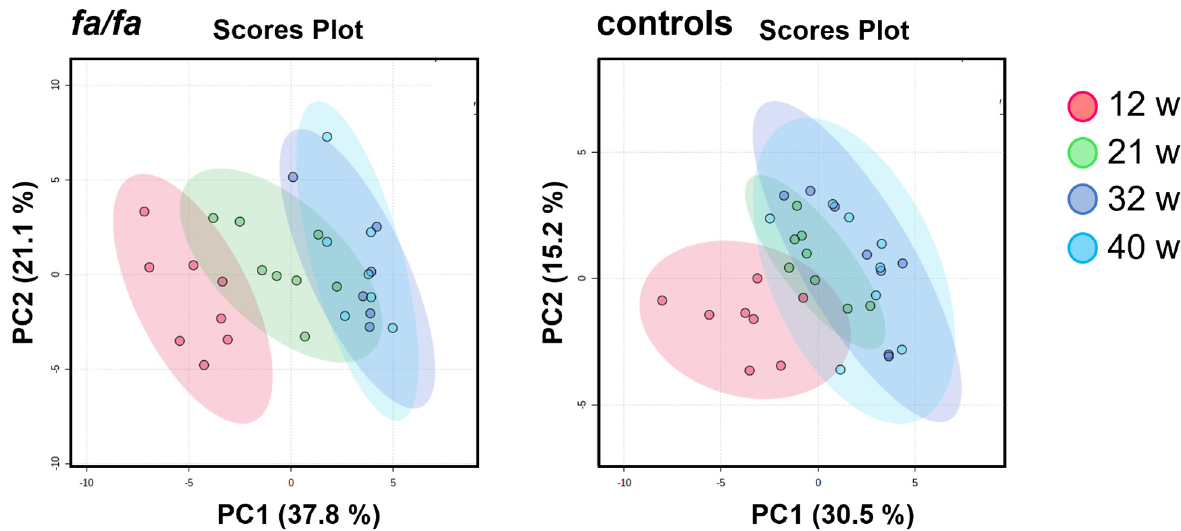
Figure 3. Score plots of PCA models of urinary profile development during aging, generated separately for fa / fa and control rats. Samples collected at 12 weeks are marked in red, at 21 weeks in green, at 32 weeks in blue, and at 40 weeks in turquoise.